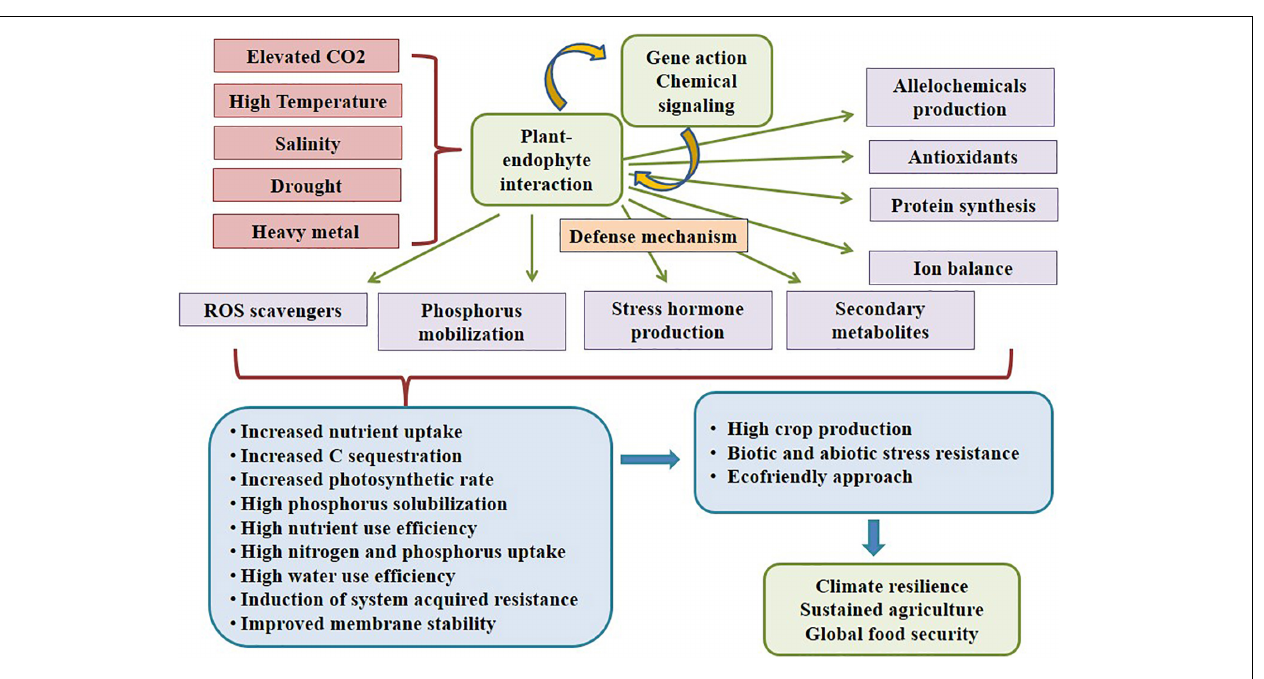
FIGURE 3 | Plant-endophyte symbiotic interaction conferring abiotic